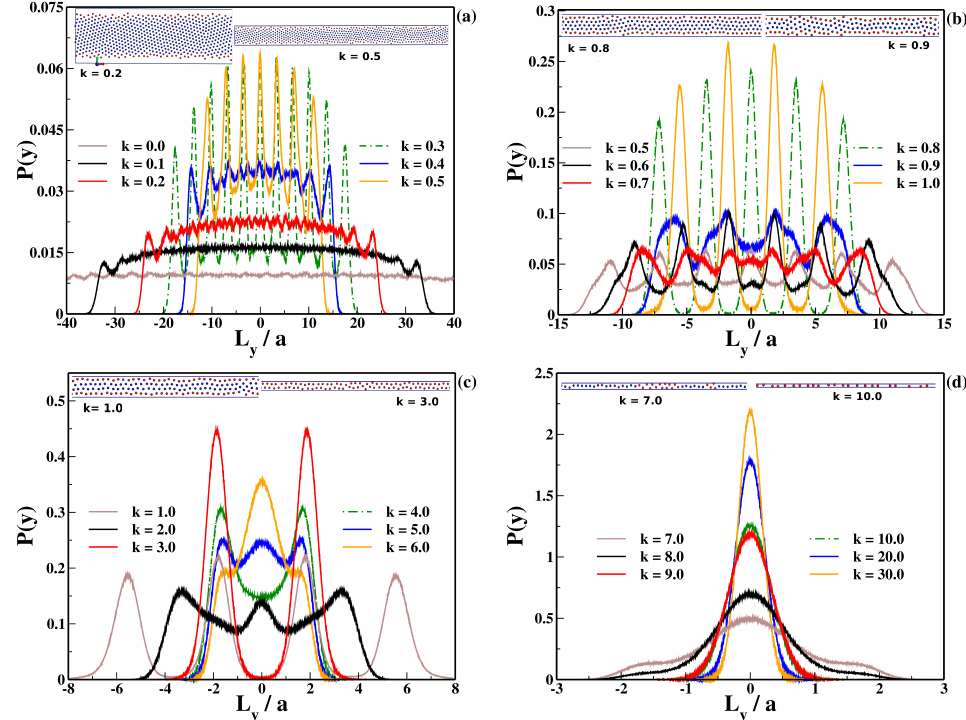
Figure 2. Probability distribution of finding a particle along the direction of confinement for ( a ) and ( b ) small, ( c ) intermediate and ( d ) strong couplings with the parabolic potential. The evolution of the number of peaks in the P ( y ) gives information of the structural transition that the system undergoes from an open 2 D system ( k = 0) to a q 2 D (0 < k ≤ 1) to q 1 D (1 < k < 9), to the final 1 D -single-file configuration ( k ≥